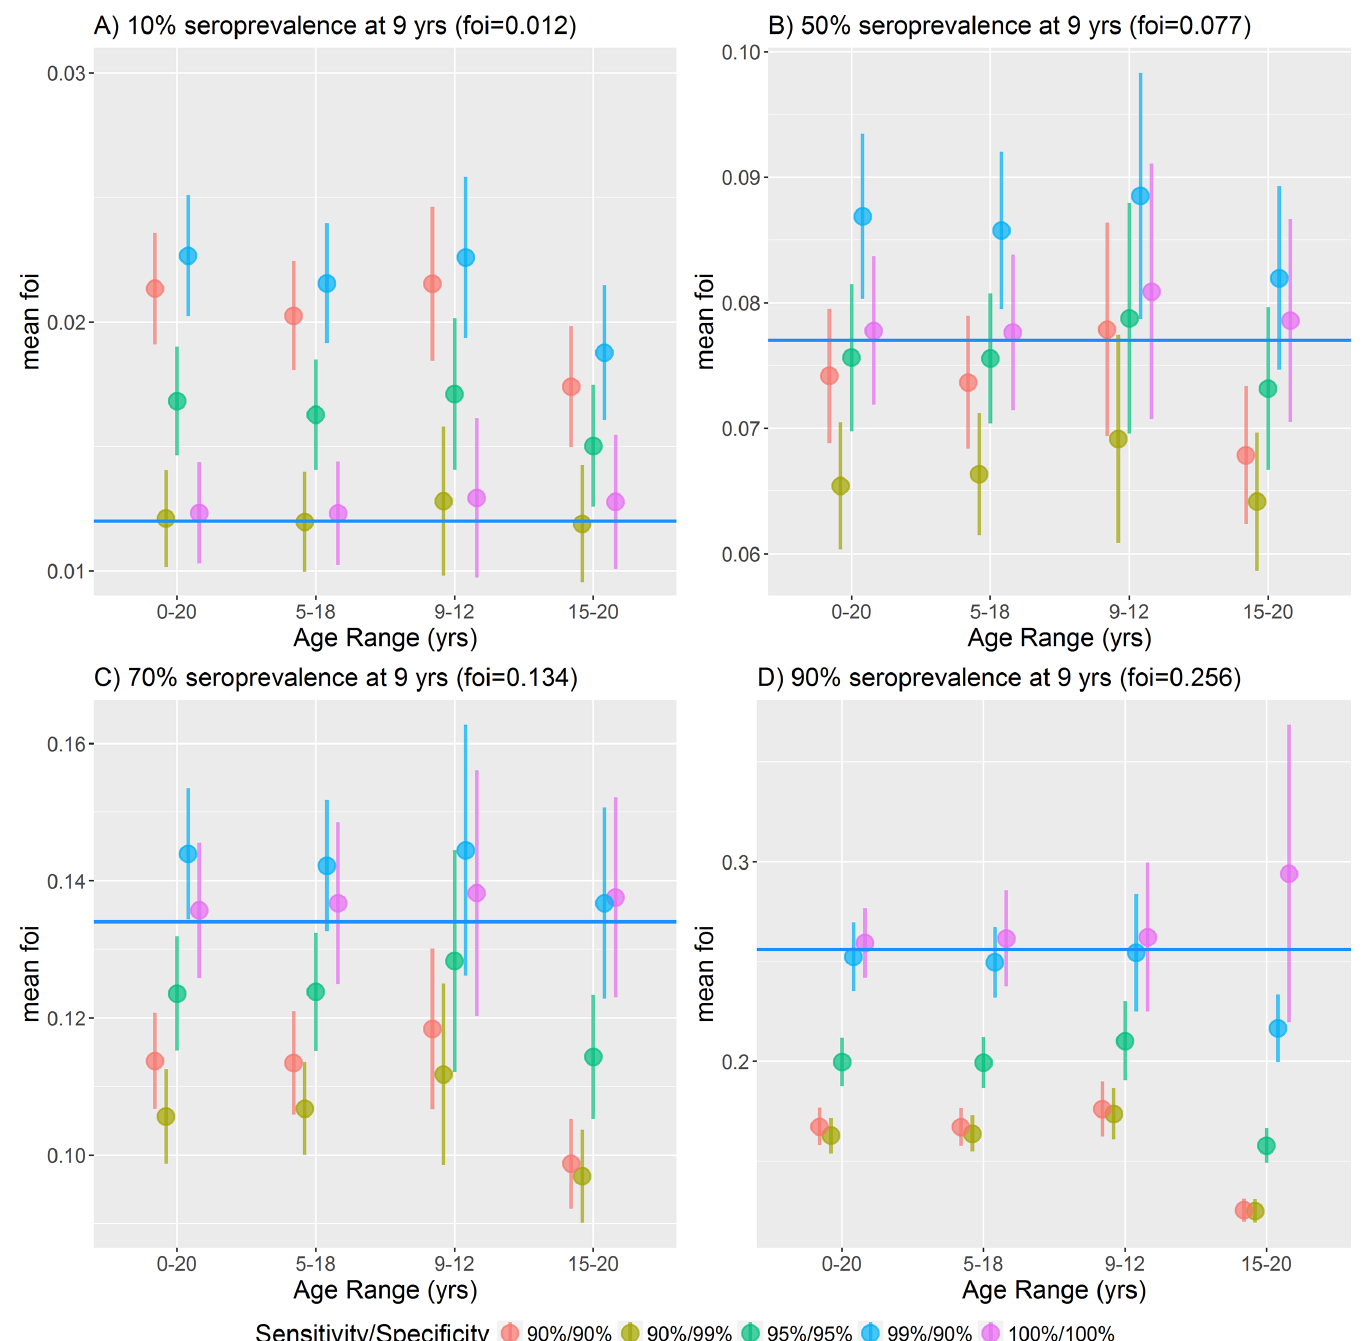
Fig 4. Dengue force of infection estimated at different transmission intensities, from a range of ages and test sensitivities and specificities, fixed survey size of 1000. A) Very low transmission 10% seroprevalence at age 9, B) medium transmission 50% seroprevalence at age 9, C) high transmission 70% seroprevalence at age 9, D) very high transmission 90% seroprevalence at age 9. The point shows the mean of the 100 mean posterior distribution of the force of infection, the bar the standard deviation, and the horizontal blue line shows the true force of